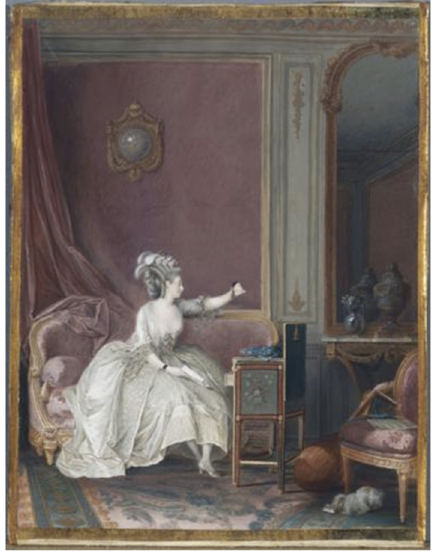
Figure 18. Nicolas Lavreince (Swedish, 1737–1807), La Consolation de l’absence , 1785, Gouache, V é lin, 25 cm × 20.5 cm, Mus é e Cognacq-Jay, le goût du XVIIIe,